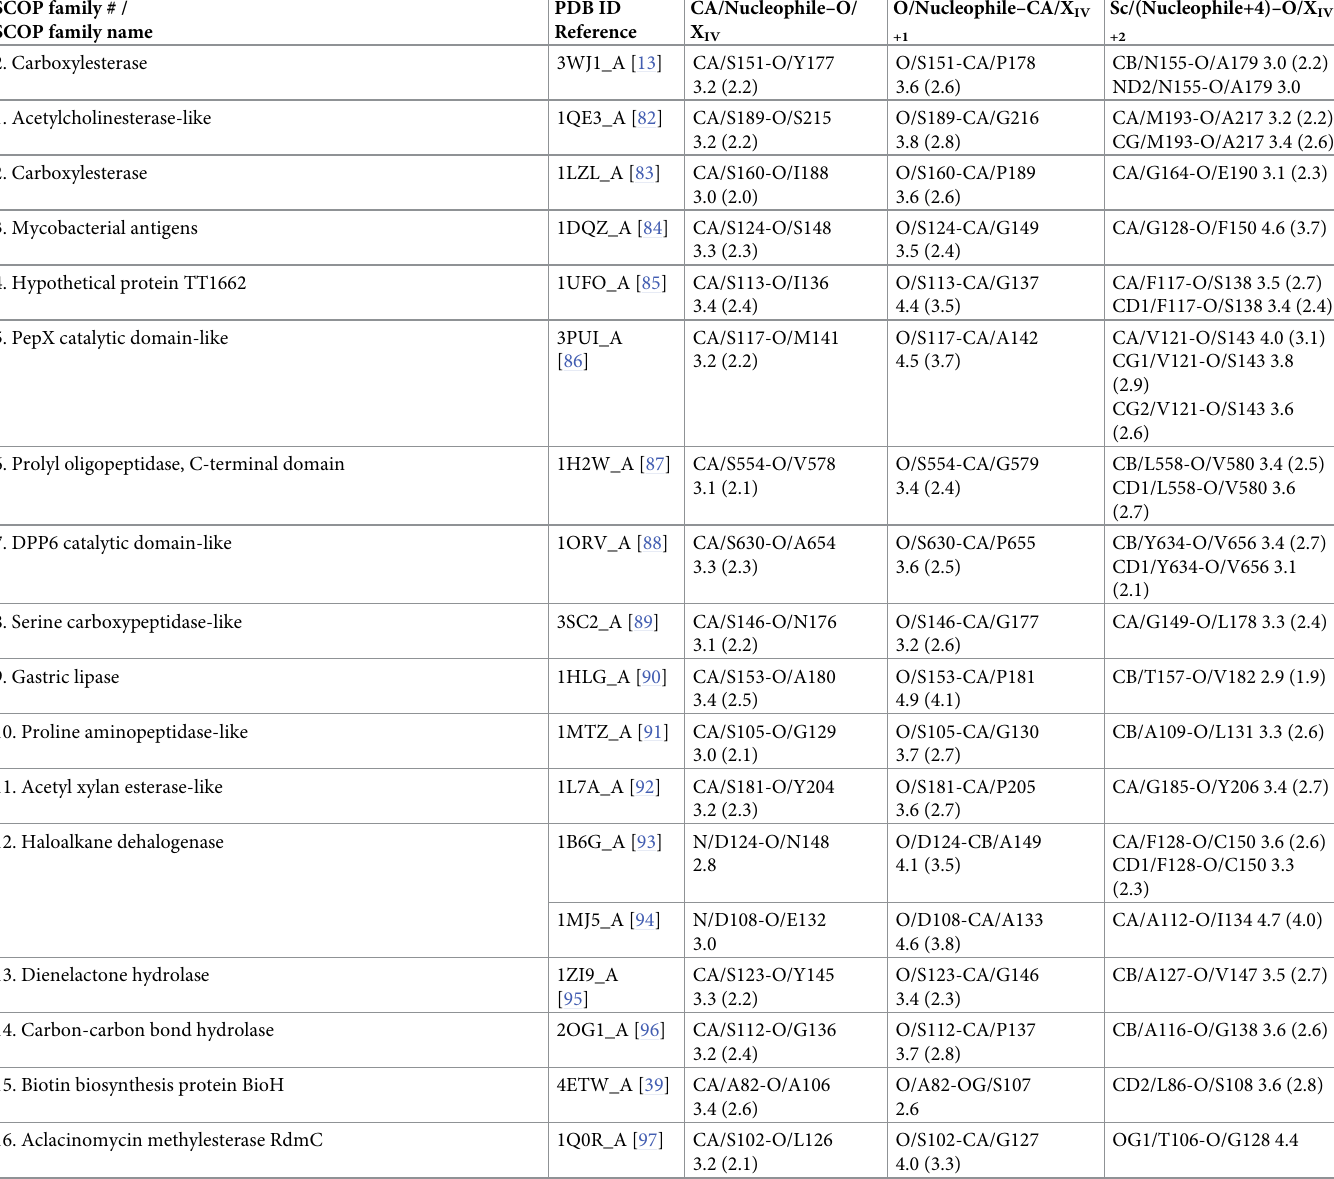
Table 1. Inventory of interactions that participate in the proper positioning of the catalytic histidine next to the catalytic nucleophile in 40 ABH fold enzyme fami- lies. The main-chain oxygen atom of residue X IV interacts with both the catalytic histidine and the catalytic nucleophile (column CA/Nucleophile–O/X IV ), orienting the imidazole ring of the catalytic histidine with respect to the side-chain of the catalytic nucleophile. Residue X IV+1 also interacts with the catalytic nucleophile (column O/ Nucleophile–CA/X IV+1 ) and thus, has an indirect influence on the optimal arrangement of the catalytic histidine-nucleophile pair. Unrelated to the coordination of the cat- alytic residues, an additional conserved contact (column Sc/(Nucleophile+4)–O/X IV+2 ) is formed between the residue that is located four positions after the catalytic nucle- ophile and the residue that is located two positions after residue X IV ; this conserved contact is formed close to the catalytic nucleophile, residue X IV and residue X IV+1 . In the second row of the table, the interactions from the carboxylesterase SshEstI (SCOP family #2, PDB ID:3WJ1_A) are listed, corresponding to the interactions that are illustrated in Fig 2. In four ABH fold families [SCOP families #12 (PDB ID:1MJ5_A), #23, #27 and #29], residue X IV is the catalytic acid residue. SCOP family #12 is repre- sented by two structures in order to properly reflect the local structural variations in ABH fold enzymes that have their catalytic acid at the canonical position (i.e. at